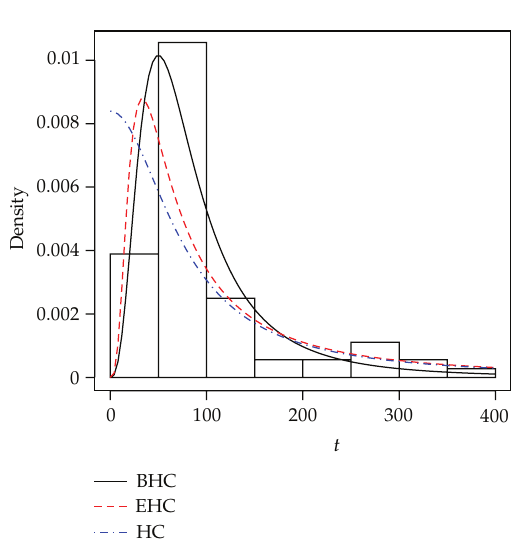
Figure 4: Estimated densities of the BHC, EHC and HC models.